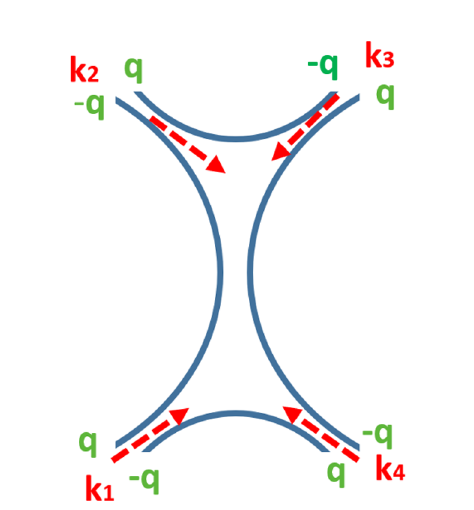
Figure 5 . The tree level amplitude of a 2 ! 2 scattering of strings with ( q; (cid:0) q ) charges on their ends. This worldsheet can be mapped to a disk with a charge q running along its